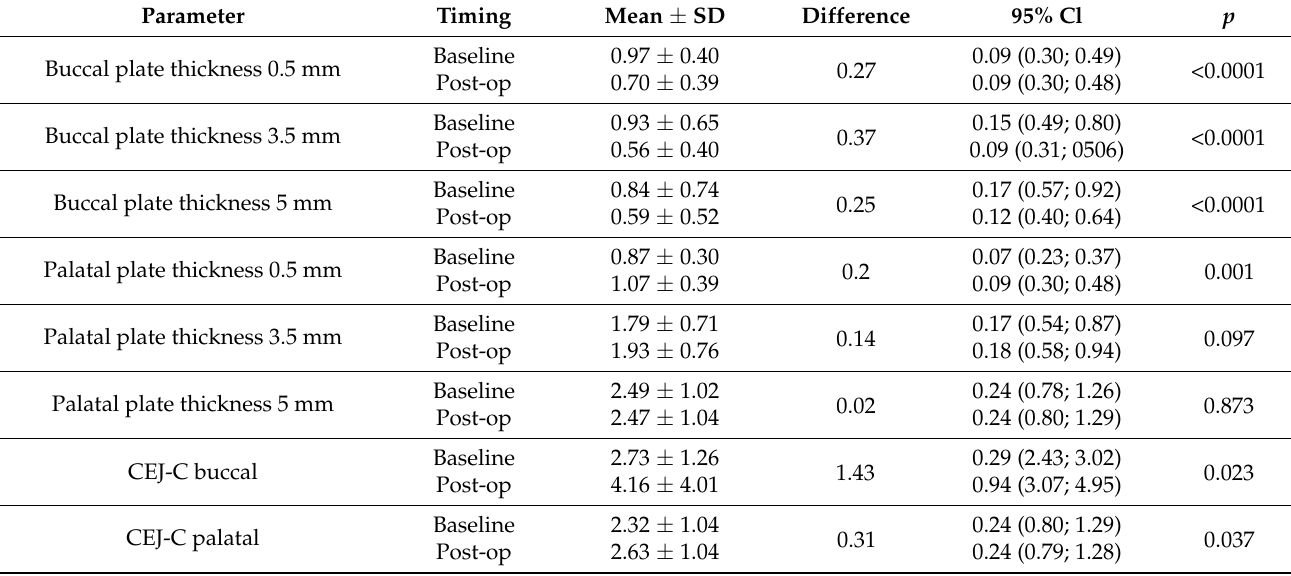
Table 5. Distribution of CBCT parameters for premolars before and after orthodontic treatment.